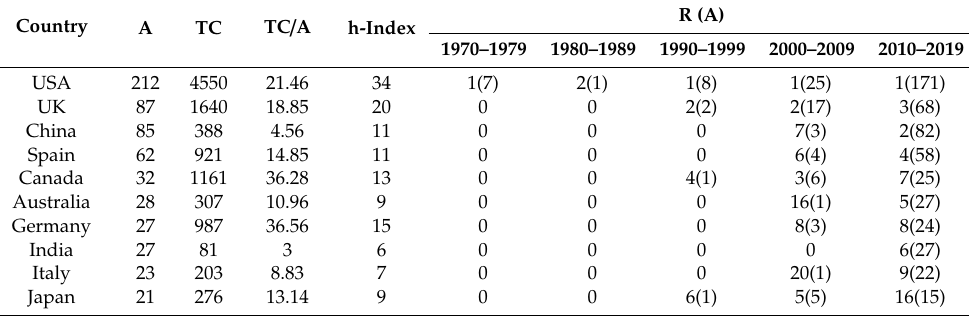
Table 7. The most productive countries in number of articles (1970–2019).